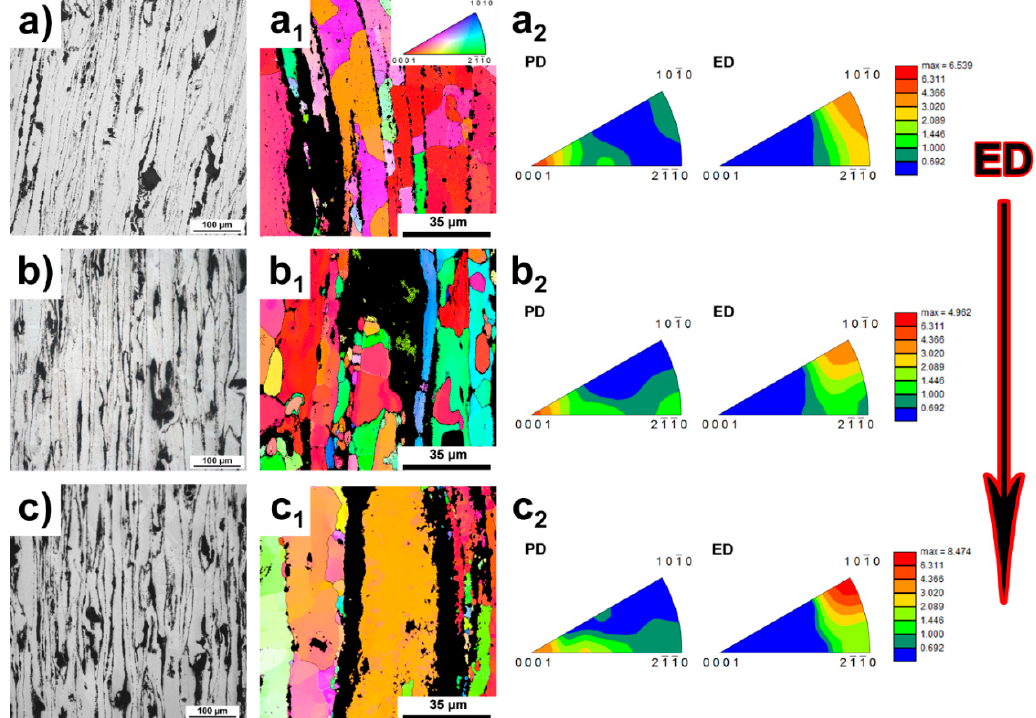
Figure 3. Microstructure ( a – c ), inverse pole figure maps ( a 1 – c 1 ) and IPF ( a 2 – c 2 ) of extruded ( a ) Zn-4MO, ( b ) Zn-4HA and ( c ) Zn-8HA. The black spots (in IPF unindexed points) characterize the ceramic particles. Table 4. Theoretical porosity of the materials.